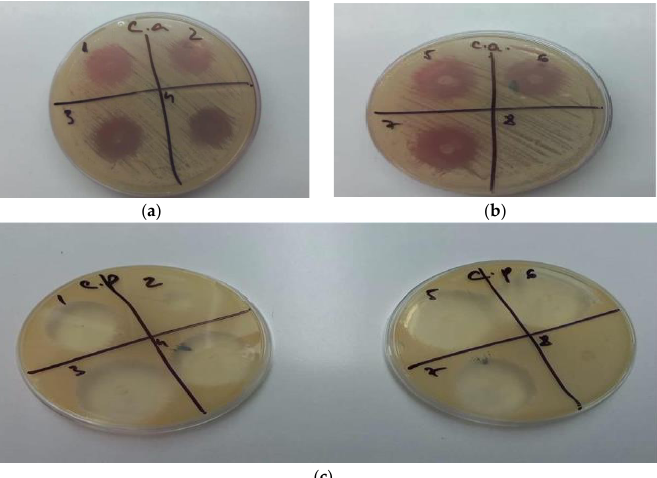
Figure 7. ( a ) GM1 – GM4 (1 – 4) inhibition of Candida albicans ; ( b ) GM5 – GM7 (5 – 7), GO5 (8) inhibition of Candida albicans; ( c ) GM1 – GM7 (1 – 7), GO5 (8) inhibition of Candida parapsilosis . Figure 7. ( a ) GM1–GM4 (1–4) inhibition of Candida albicans ; ( b ) GM5–GM7 (5–7), GO5 (8) inhibition of Candida albicans; ( c ) GM1–GM7 (1–7), GO5 (8) inhibition of Candida parapsilosis